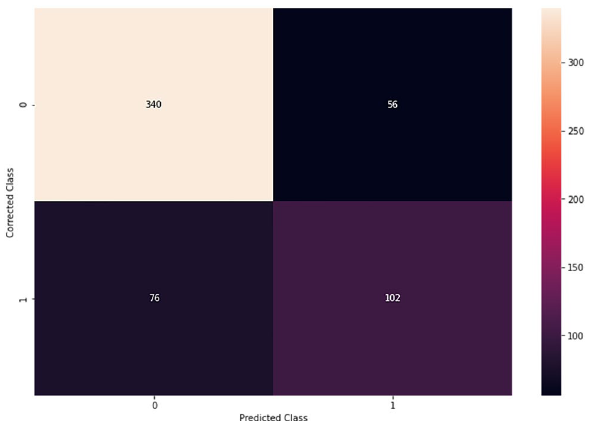
Figure 4. Confusion matrix values during the test. 0 indicates no presence of NAFLD, 1 indicates presence of NAFLD.